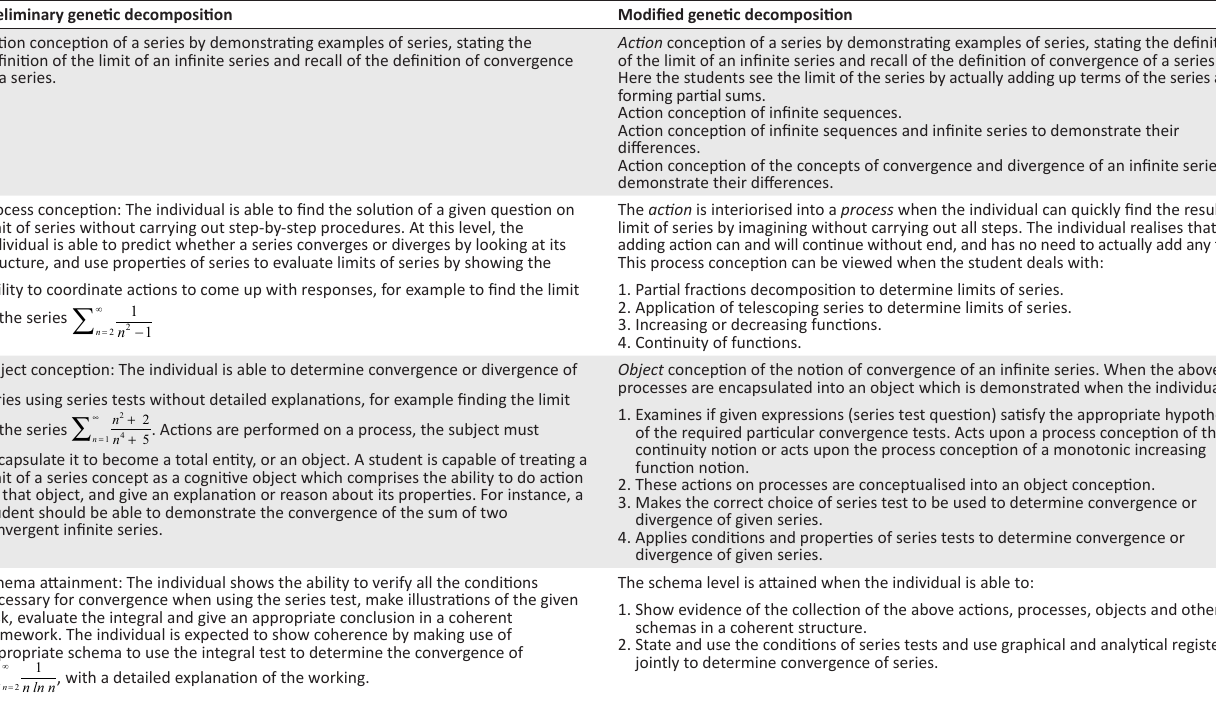
TABLE 10: Preliminary and modified genetic decompositions for